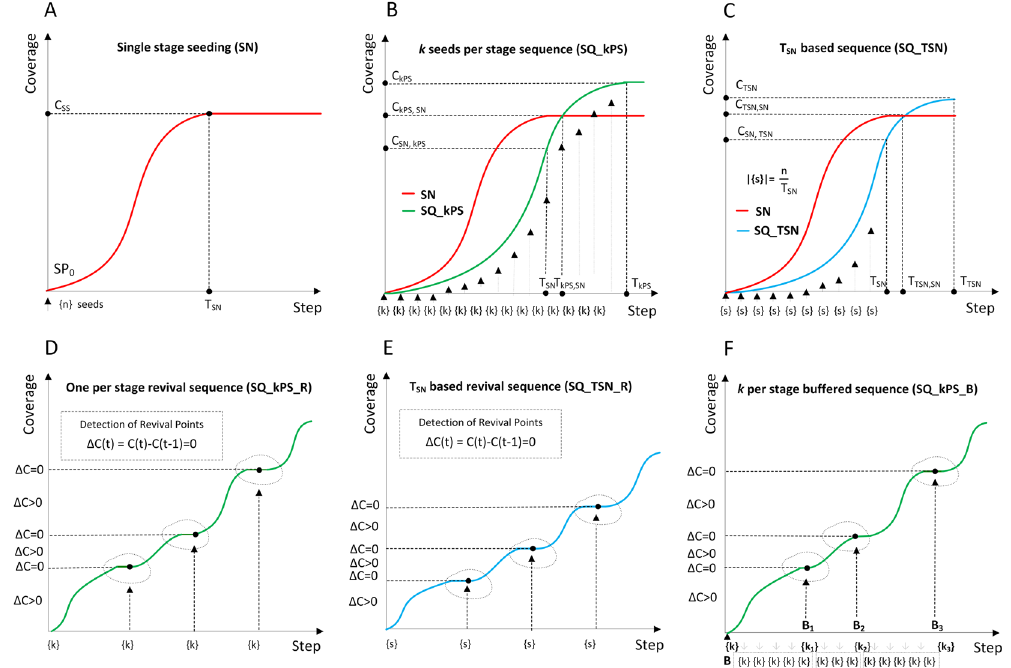
Figure 4. ( A ) Diffusion based on the single stage seeding. ( B ) k per stage sequential seeding strategy SQ_kPS. ( C ) Sequential seeding based on reference time T SN – SQ_TSN. ( D ) k per stage sequential seeding strategy with the revival mode SQ_kPS_R. ( E ) The T SN -based sequential seeding with the revival mode SQ_TSN_R. ( F ) k per stage sequential seeding with buffering